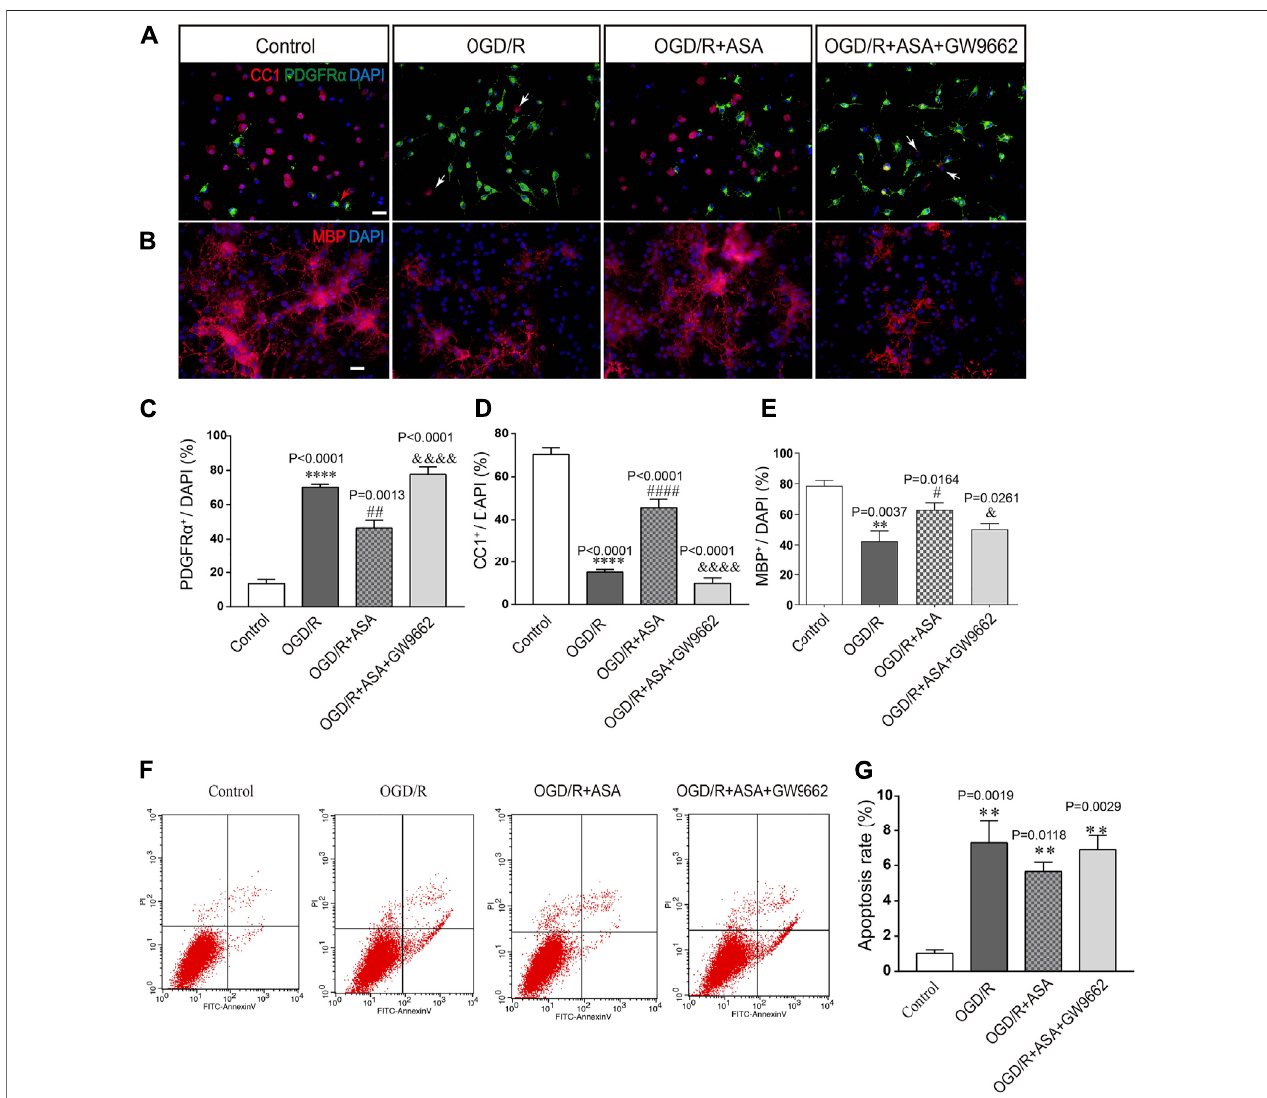
FIGURE 8 | Conditioned medium from α -asaronol-treated astrocytes promotes OPC differentiation without in fl uencing apoptosis. Representative immuno fl uorescence images for PDGFR α -labeled OPCs and CC1-labeled mature OLs (A) and MBP-labeled myelin sheath (B) . Scale bar, 20 µm. (C – E) Statistical analysisofthenumbers ofPDGFR α + cells,CC1 + cells,and MBP + cells. (E,F) Representative fl owcytometry images ofOPCs and quantitative analysisofthepercentage of apoptotic cells for all groups. Scale bar, 20 µm. All data are represented as the mean ± SEM. ** p < 0.01, **** p < 0.0001 vs. the control group. # p < 0.05, ## p < 0.01, #### p < 0.0001 vs. the OGD/R group. & p < 0.05, &&&& p < 0.001 vs. the OGD/R + ASA group. N = 4 per